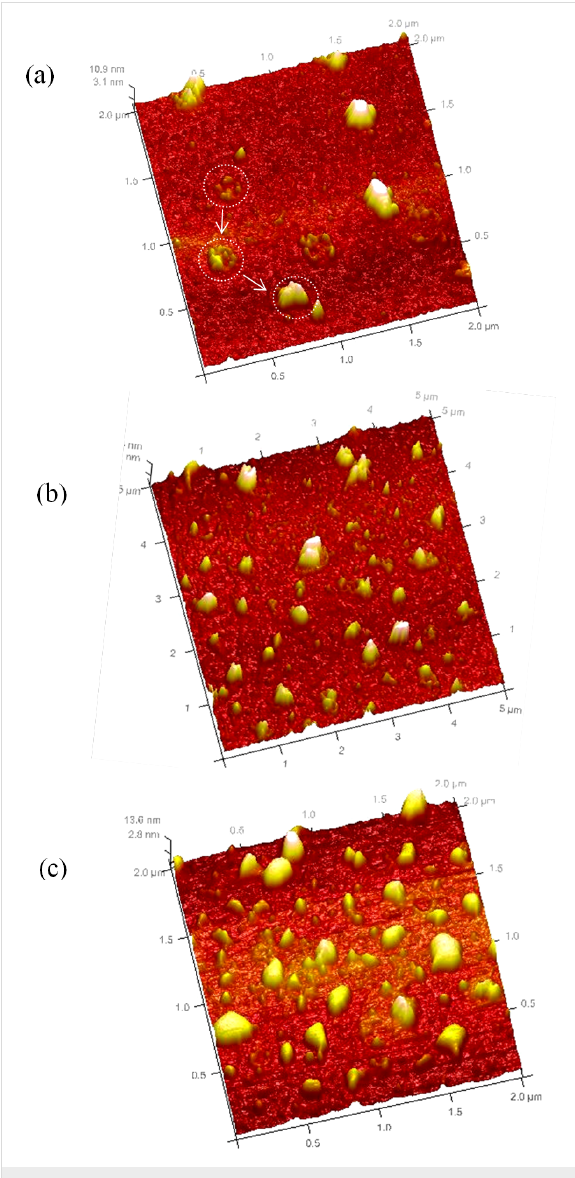
Figure 2: AFM images showing size evolution of CdS particles grown on mesoporous TiO 2 with different number of deposition cycles (a) 5×CdS/TiO 2 , (b) 7×CdS/TiO 2 and (c) 15×CdS/TiO 2 . Figure 3: TEM image of the for 15×CdS/TiO 2